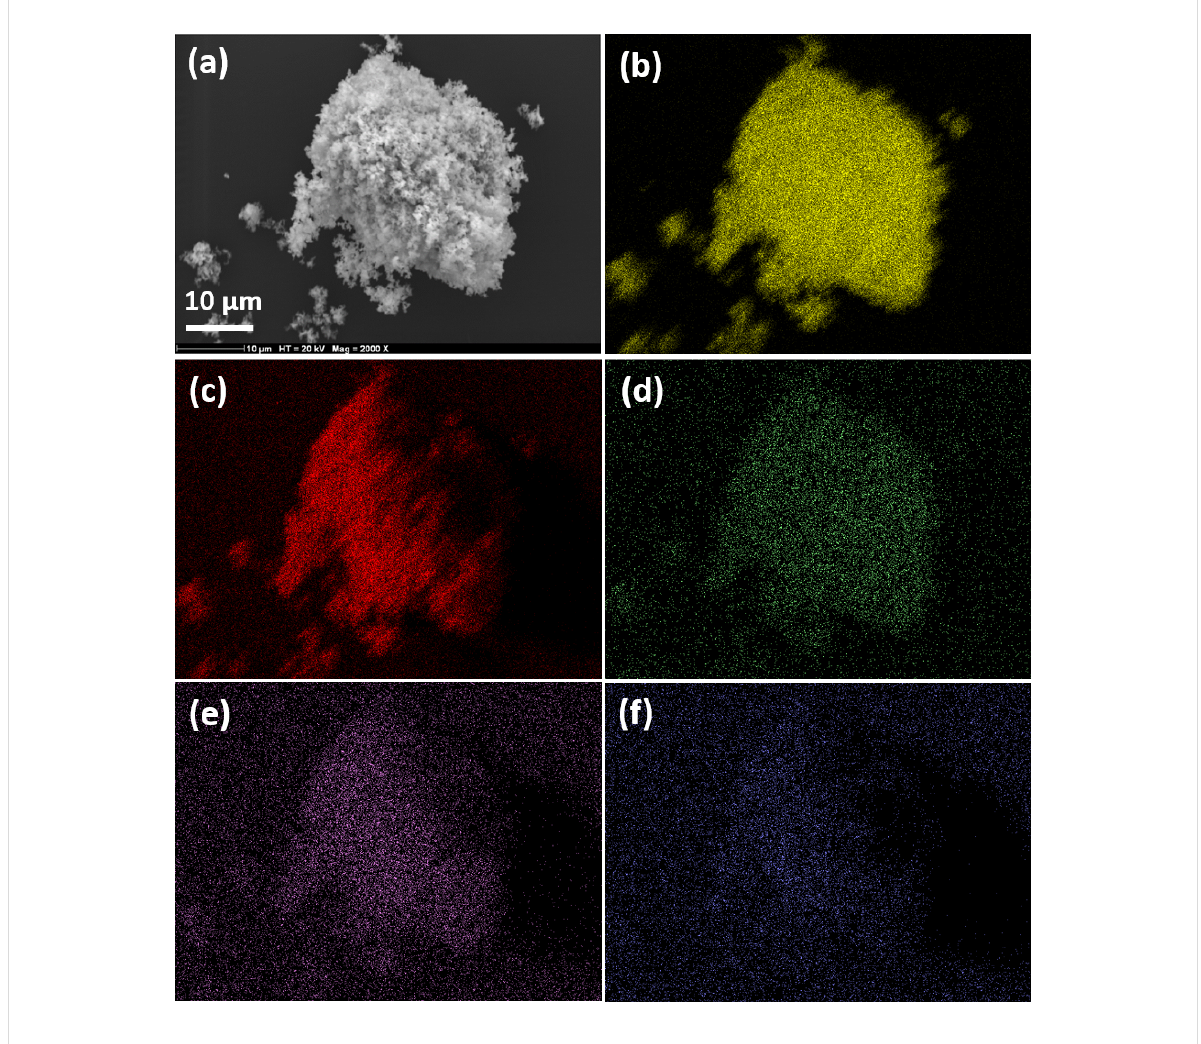
Figure 2: (a) SEM image of the ZnO/ZCIS composite. Elemental mapping of the ZnO/ZCIS composite heated at 400 °C for 15 min showing the pres- ence of (b) Zn, (c) O, (d) Cu, (e) In and (f) S elements.